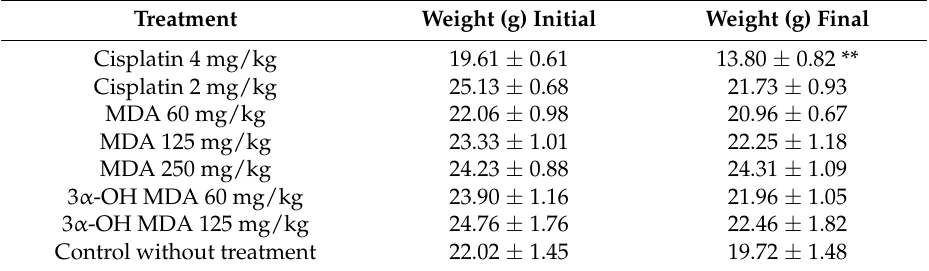
Table 2. Effect of MDA and 3 α -OH MDA on body weight of mice. The data are shown as the means ± SEM (standard error of mean) with n = 6 animals for each experimental group. ** p < 0.01 represent the statistical difference in body weight change between the beginning and end of treatment. Data were analyzed by one-way ANOVA-repeated measures.